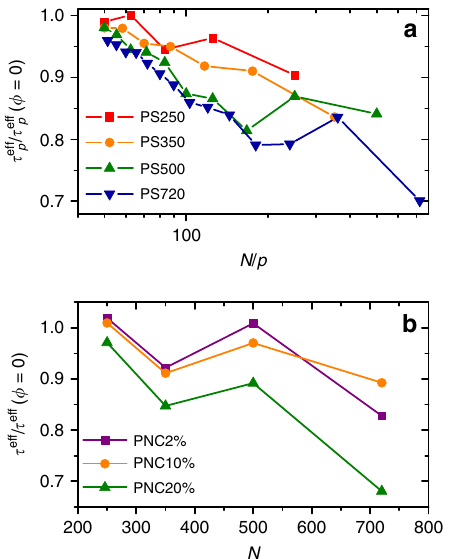
Fig. 4 Effective relaxation time ratio between composite and neat system. a The ð N = p Þ -dependent segmental effective relaxation time τ eff obtained from Rouse mode analyses is plotted for matrix chain segments with an effective length of N = p in composite systems containing 20% NP250, only values with N = p > 50 are plotted; b the N -dependent chain effective relaxation time τ eff obtained from < R ð t Þ R ð 0 Þ > , R ð t Þ is the end-to- end vector of the melt PS chain at time t . τ eff in both fi gures are normalized by corresponding values from pure melt systems τ eff ð ϕ ¼ 0 Þ .